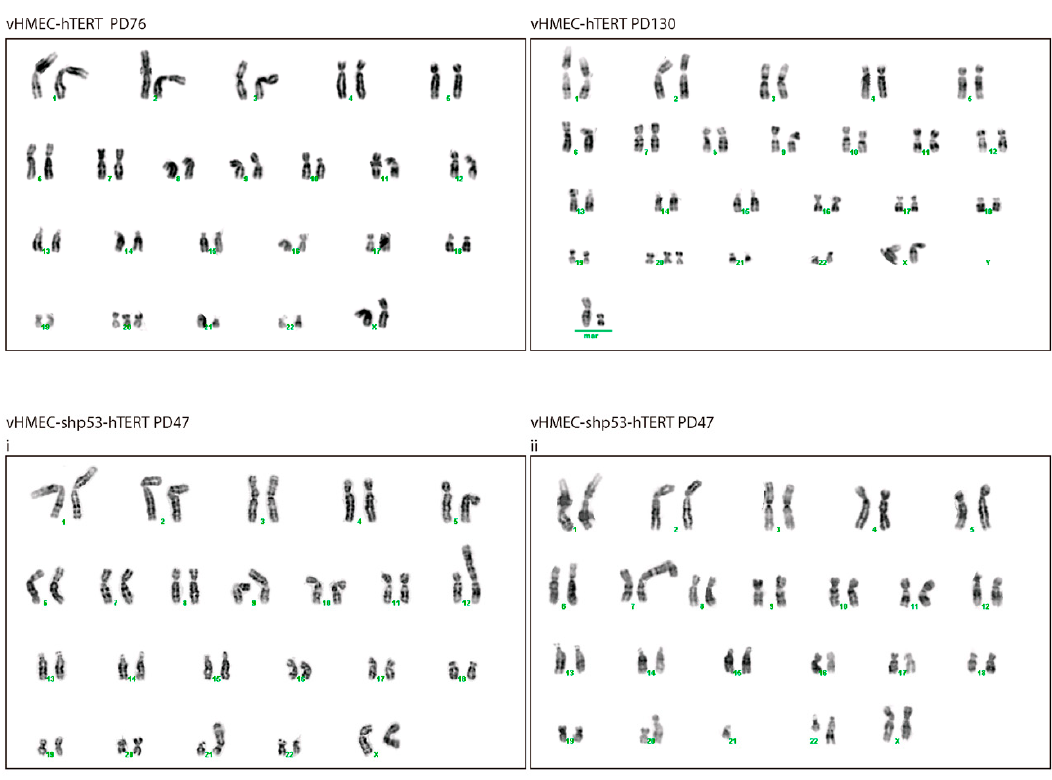
Figure 6. Karyotypes of immortalised p53-proficient and deficient vHMECs. Immortalisation of young vHMECs resulted in few chromosomal aberrations; the karyotype shown at PD76 is 47, XX, del (10p), +20. When the immortalised vHMECs were again karyotyped after 54 PDs (PD130), in addition to trisomy 20, two clonal marker chromosomes were observed. By contrast, immortalisation of p53-compromised vHMECs resulted in the accumulation of stable and unstable structural chromosome aberrations. Two karyotypes are shown: ( i ) 46, XX, nrt (9p;?), nrt (12p;?), dic (21p;?) and ( ii ) 45, XX, idic (7p;7p), +7, dic (20p;?), tric (22q;?;?), − 21.